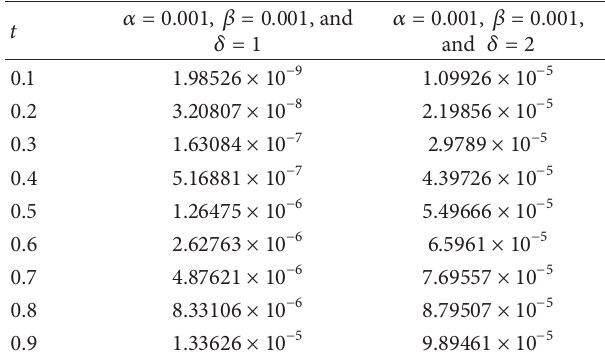
Table 7: Absolute errors of OHAM for 𝑥 = 2 and 𝑡 ∈ [0.1, 1] . 𝛼 = 0.001, 𝛽 = 0.001 , and 𝛼 = 0.001, 𝛽 = 0.001 𝑡 𝛿 = 1